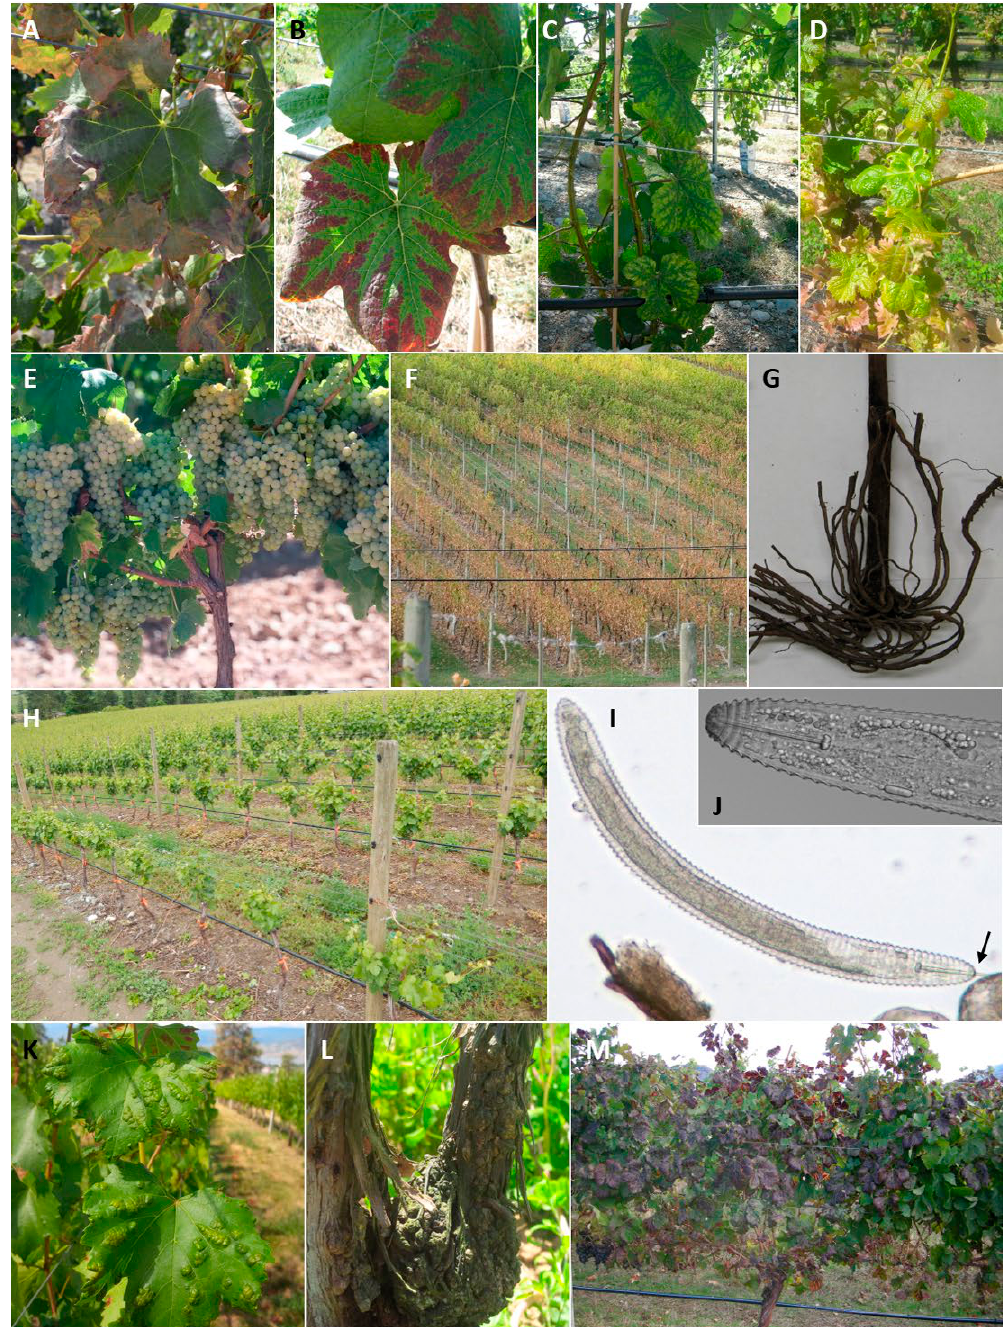
Figure 4. Abiotic and biotic stress factors hypothezised to contribute to grapevine trunk disease fungal development and symptom expres- sion. A. Leaf scorching as a result of severe vine water stress. B and C . Leaves of young vines showing nutrient deficiency. D. Leaf deformi- ties caused by herbicide damage. E. Severe over-cropping during the first years of vineyard establishment (courtesy of D. Gramaje, ICVV, Logroño, Spain). F. Winter damage and/or spring frost may favor disease development. G. J-rooting as a result of poor planting conditions. H. Low vigour vines caused by a nematode infestation. I. Ring nematode ( Mesocriconema xenoplax ) feeding on a root by introducing the stylet (black arrow). J. Close up of the ring nematode head. K. Leaf galls caused by erineum mite ( Colomerus vitis ). High levels of insect damage could increase vine stress. L. Grapevine crown gall caused by Agrobacterium vitis . M. Grapevine showing grapevine leaf roll symp- toms caused by Grapevine leafroll-associated virus 3 . Grapevines affected by biotic stress factors (fungal, bacterial or virus diseases) may favour GTD fungal infections, wood colonization and symptom